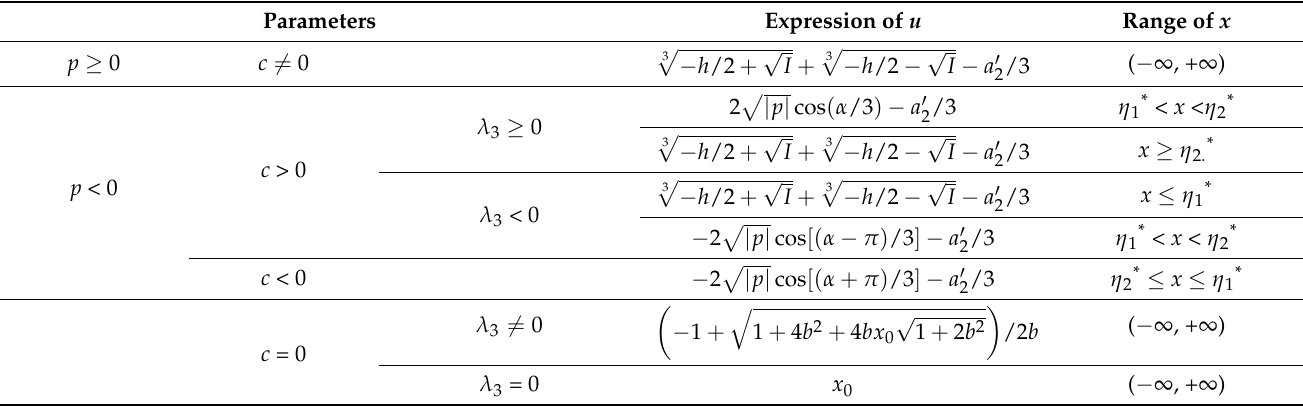
Table 1. Expressions of u